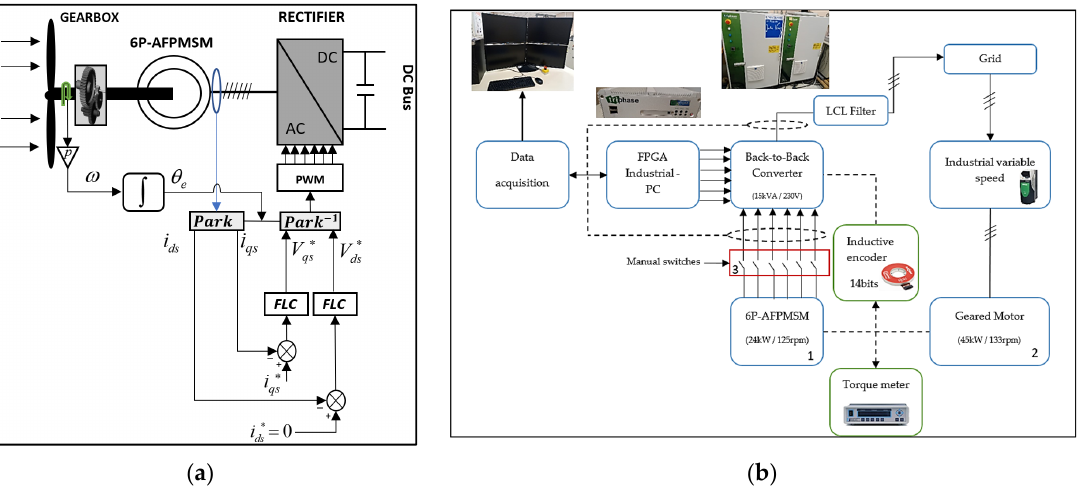
Figure 5. ( a ) Control scheme of 6P-AFPMSM; ( b ) Diagram of the experimental setup.